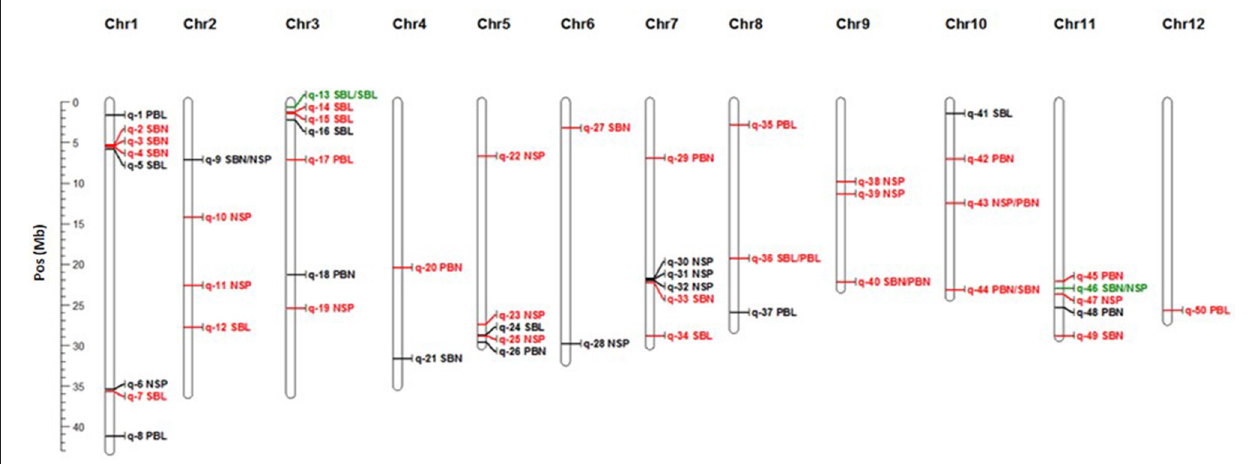
FIGURE 3 | Physical map position of significant GWAS sites detected through MLM1. In red GWAS sites for Exp1-TR, in black GWAS site for Exp2-DRS and in green GWAS sites across experiments. Co-locations are represented by “/” between